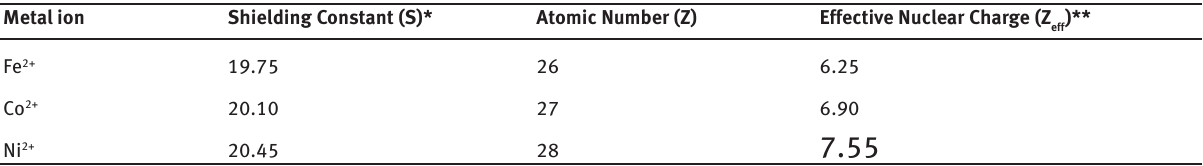
) of metal complexes [20]. eff